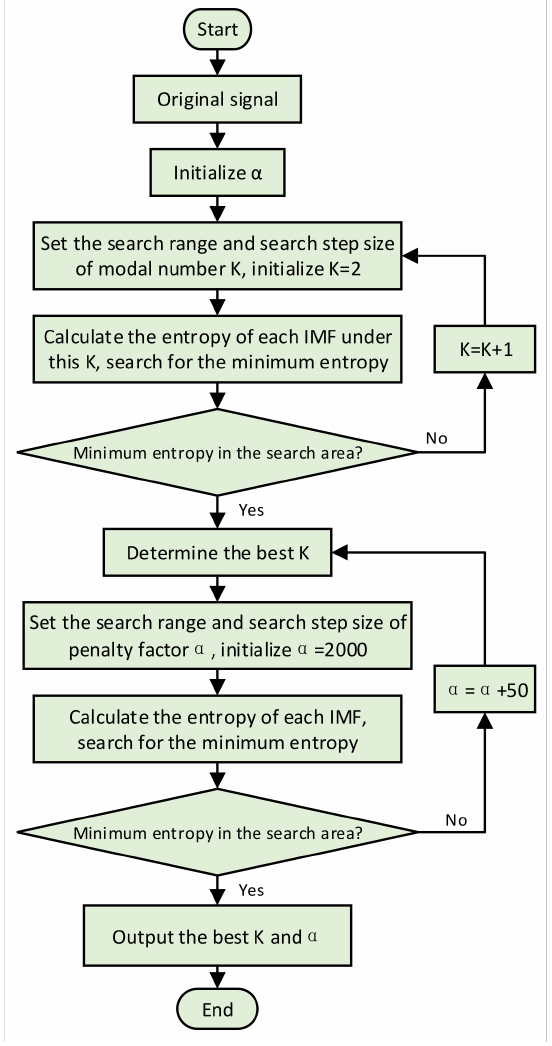
Figure 1. VMD parameter adaptive selection flow